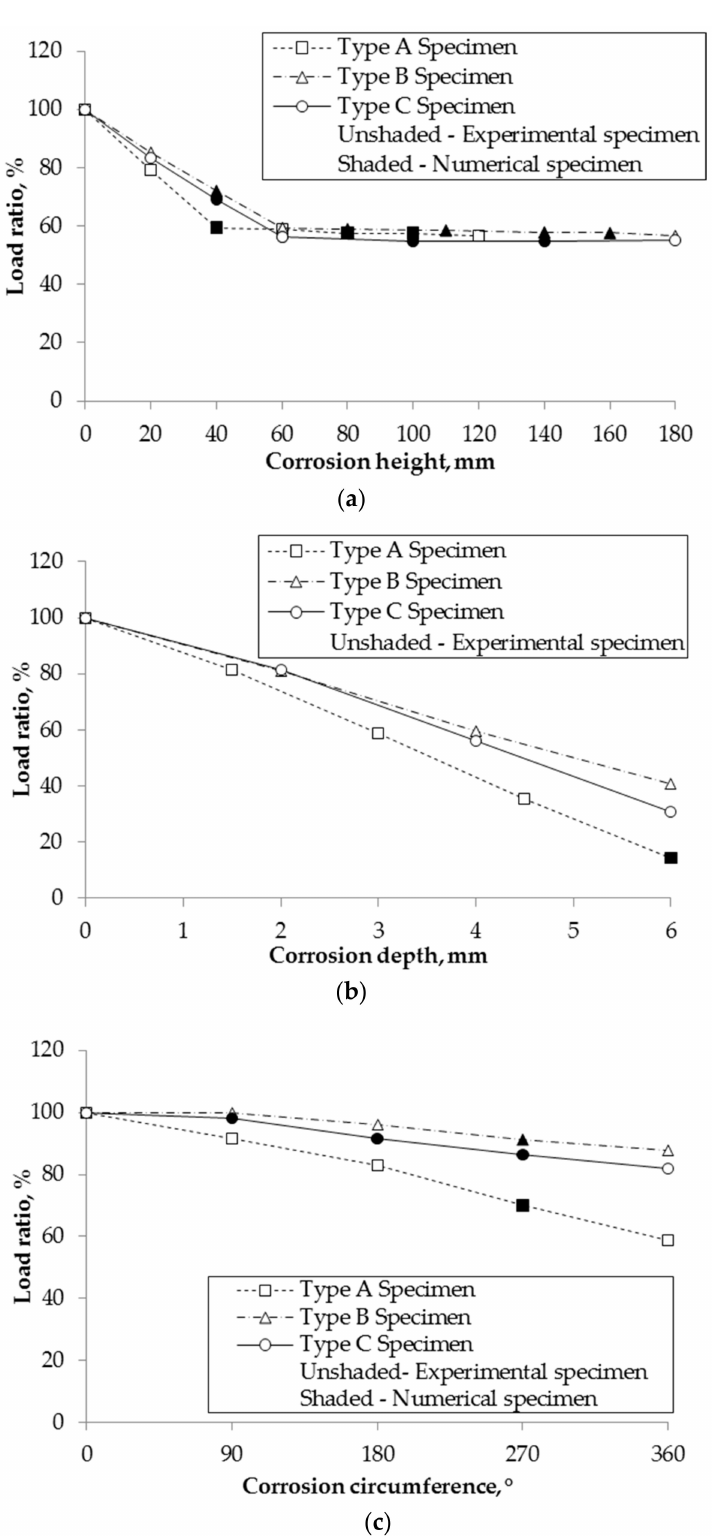
Figure 11. Relationship of residual compressive strength and corrosion level: ( a ) Load ratio with respect to corrosion height; ( b ) Load ratio with respect to corrosion depth; ( c ) Load ratio with respect to corrosion